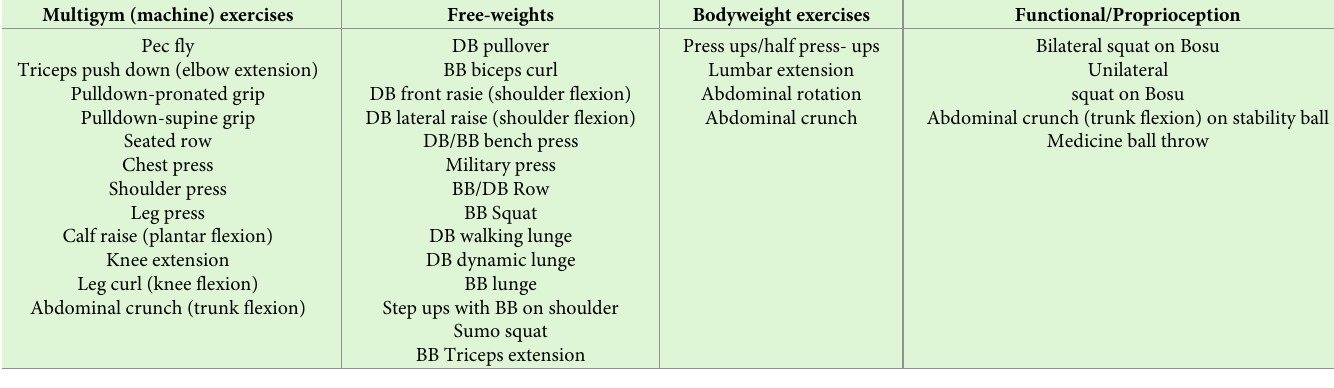
Table 1. Overview of exercises used in resistance training program. Multigym (machine)